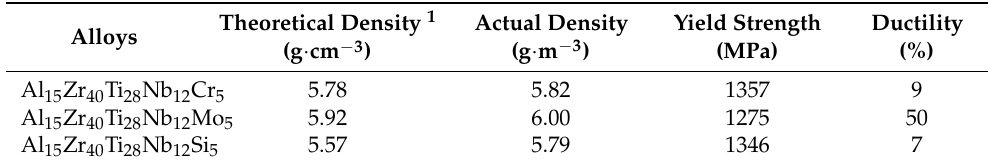
Table 1. The theoretical densities, actual density and properties of the Al 15 Zr 40 Ti 28 Nb 12 M 5 (Cr, Mo, Si) alloys.